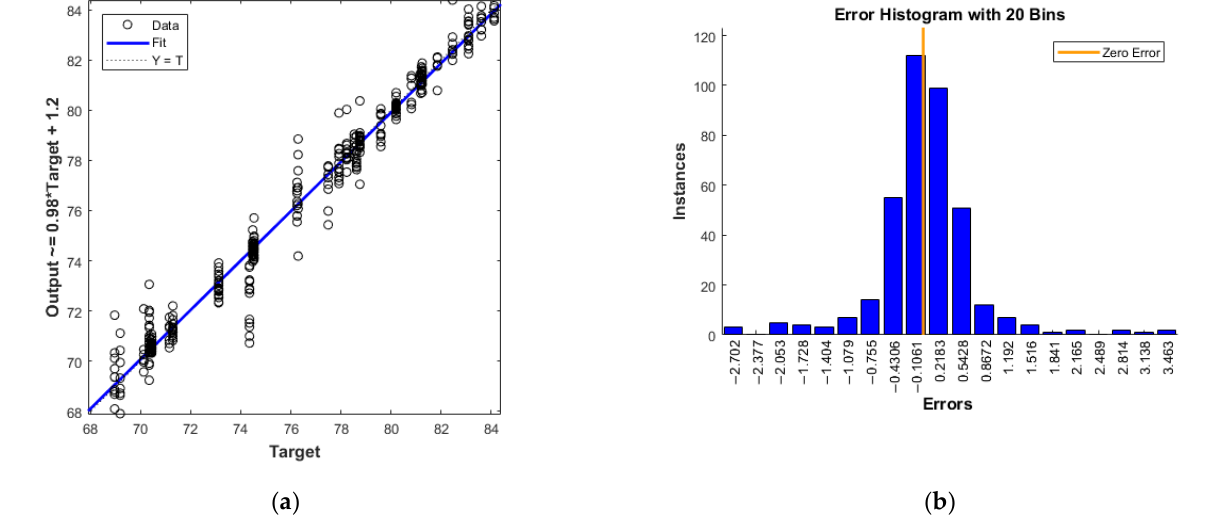
Figure 4. Results of the linear regression ( a ) and error histogram ( b ) for the test dataset and the MLP 33-10-1 VS10 model for the prediction of the volatile solids content.